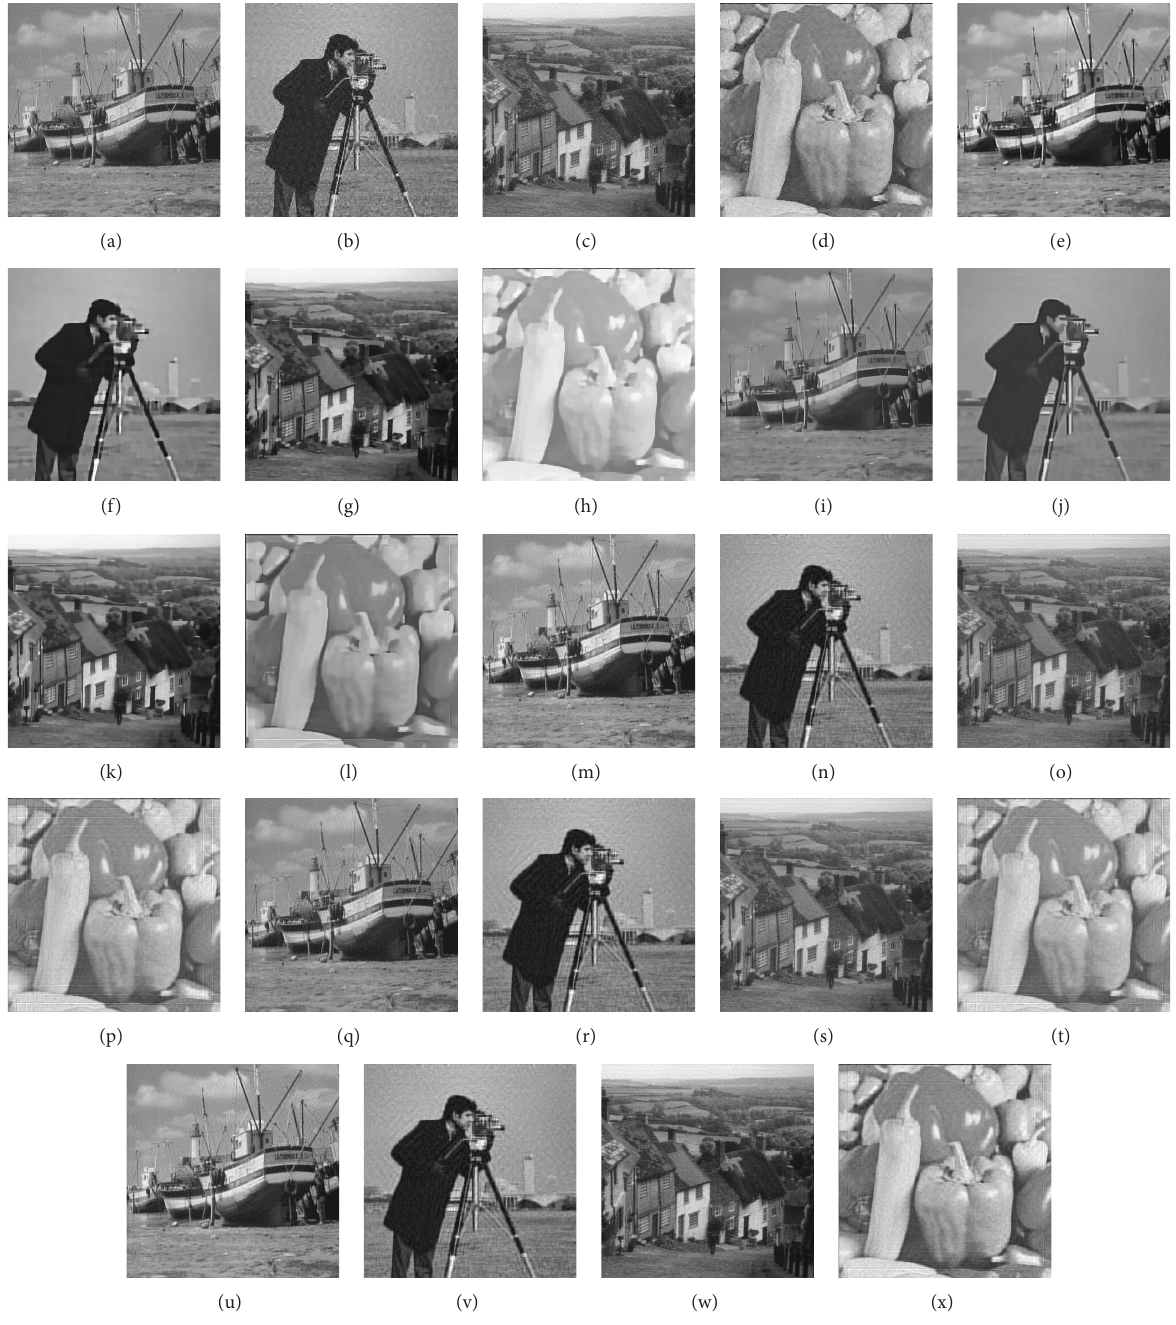
Figure 5: Restored average blurred-noisy images obtained by ((a)–(d)) DeblurSps, ((e)–(h)) TV BOS, ((i)–(l)) NLTV BOS, ((m)–(p)) SBMTV 1/4 , ((q)–(t)) SBMTV 1/3 , and ((u)–(x)) SBMTV 4/5